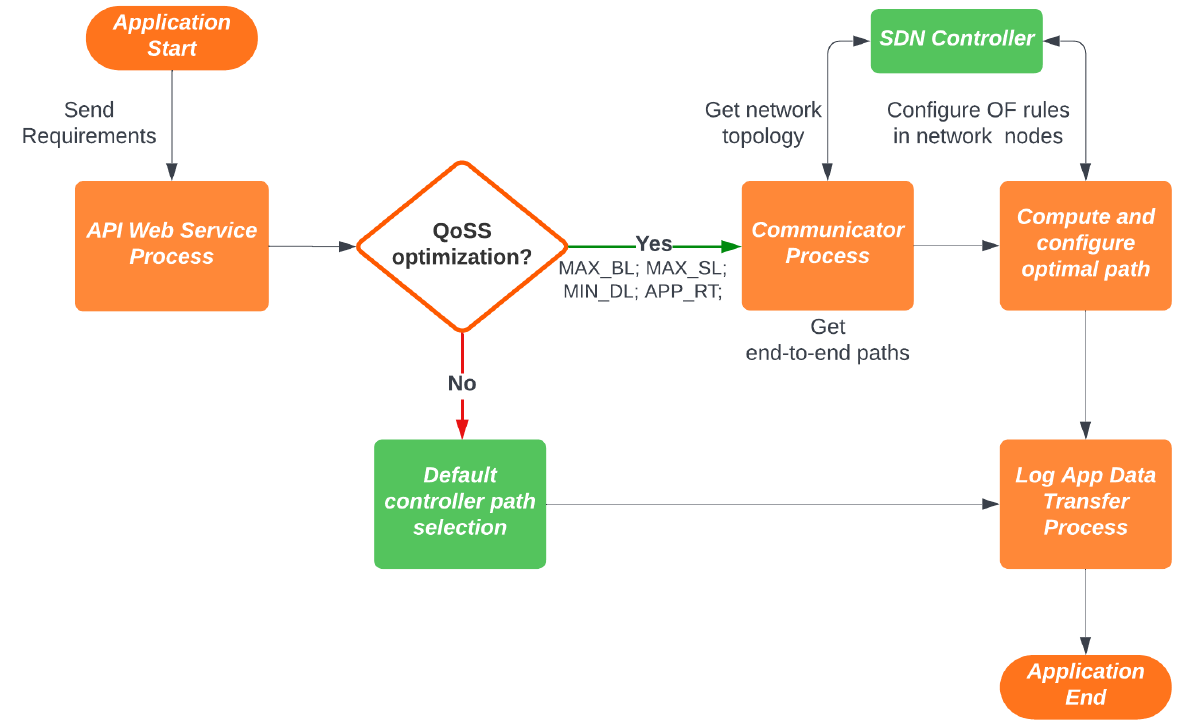
Figure 3. QoSS General